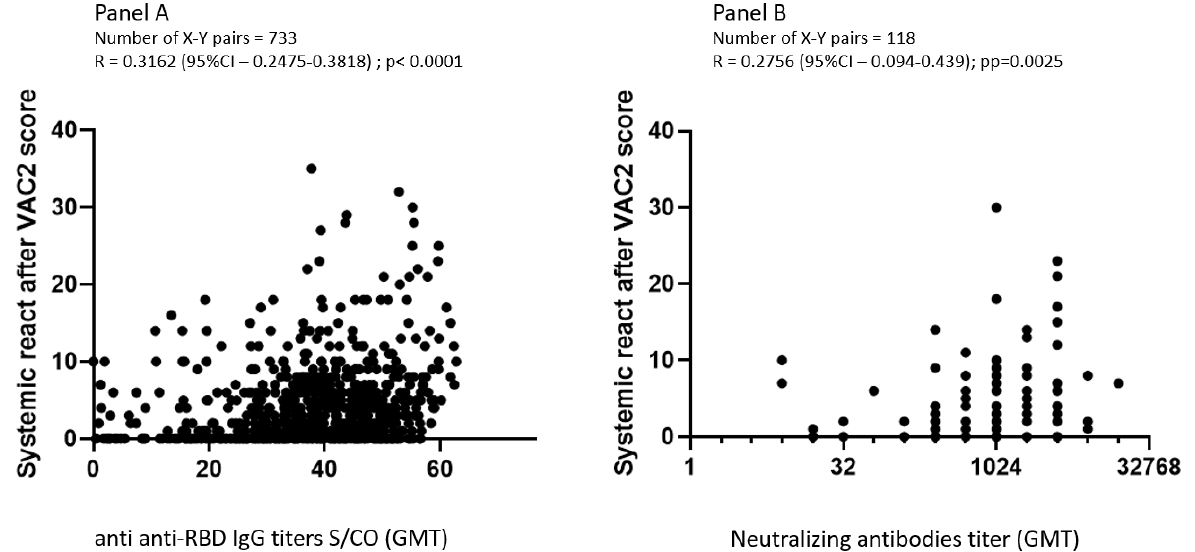
Figure 2. Correlation between reactogenicity score and immunogenicity as measured with anti-RBD IgG ( panel A ) and neutralizing antibodies ( panel B ), Spearman correlation coefficient.